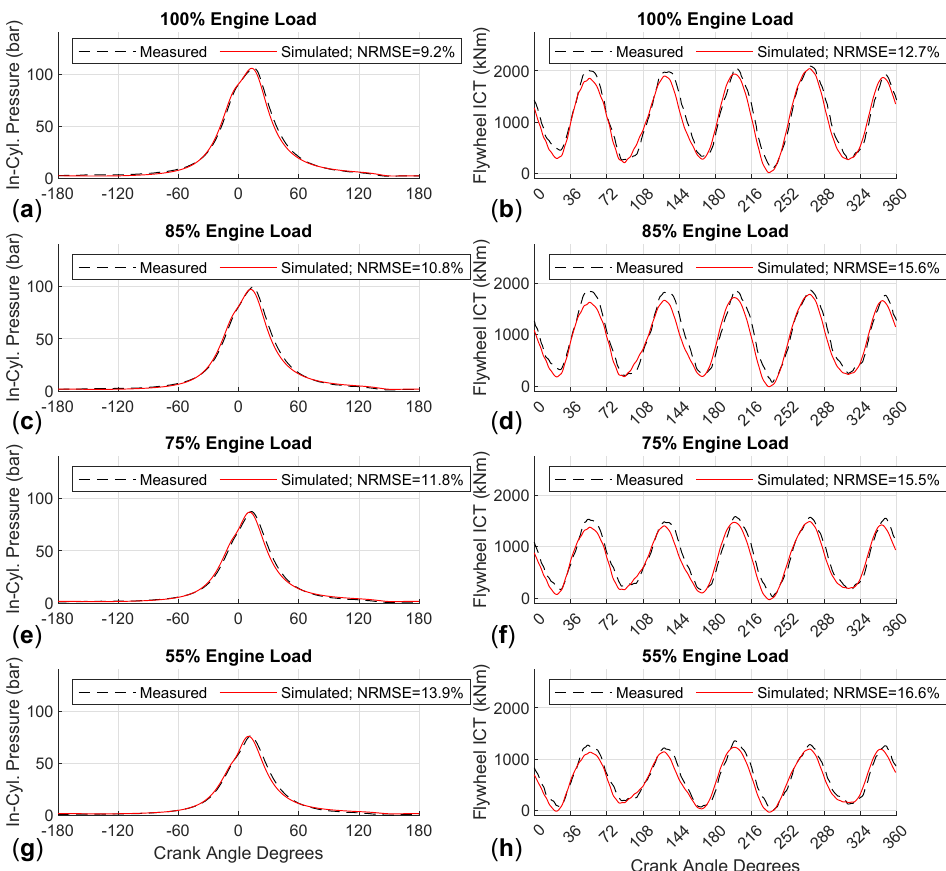
Figure 3. In-cylinder pressure at ( a ) 100%, ( c ) 85%, ( e ) 75% and ( g ) 55% engine load. Flywheel ICT at ( b ) 100%, ( d ) 85%, ( f ) 75% and ( h ) 55% engine